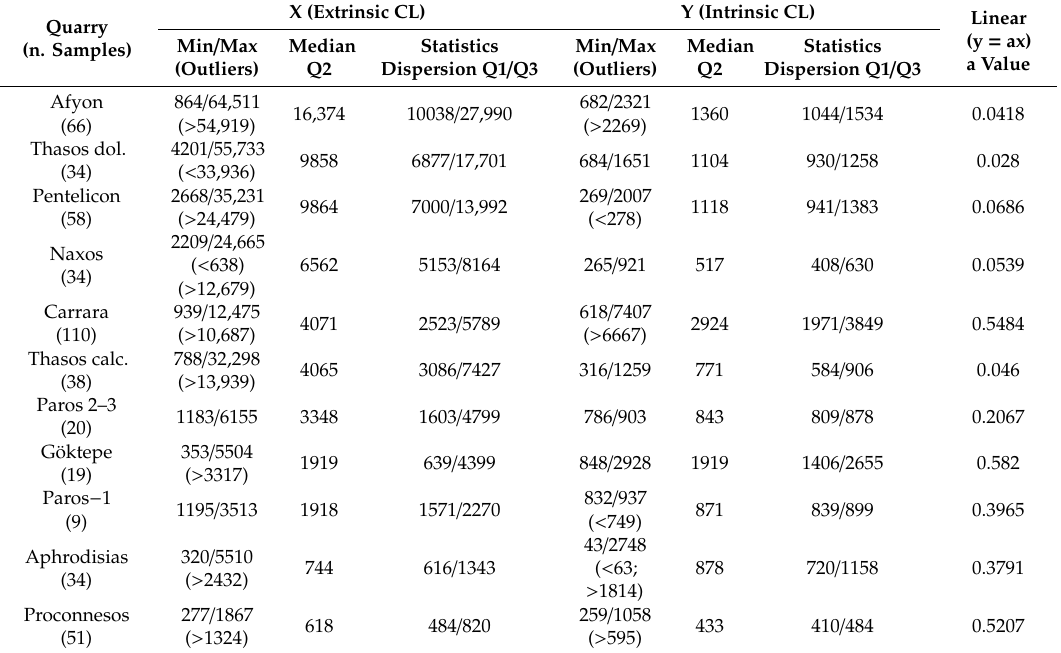
Table 1. Quantitative CL of the main marbles used in antiquity, expressed by the intensity statistics values of the spectra. X (peak at 620–650 nm, or extrinsic CL) and Y (sum of peaks at UV, or intrinsic CL). Minimum (Min), maximum (Max), Q1 (25th percentile), Q2 (median), Q3 (75th percentile). Outliers (values 1.5 times out of the interquartile range). The slope ( a ) values are obtained from the linear representation of all samples in each quarry. They are listed in decreasing order of their median extrinsic